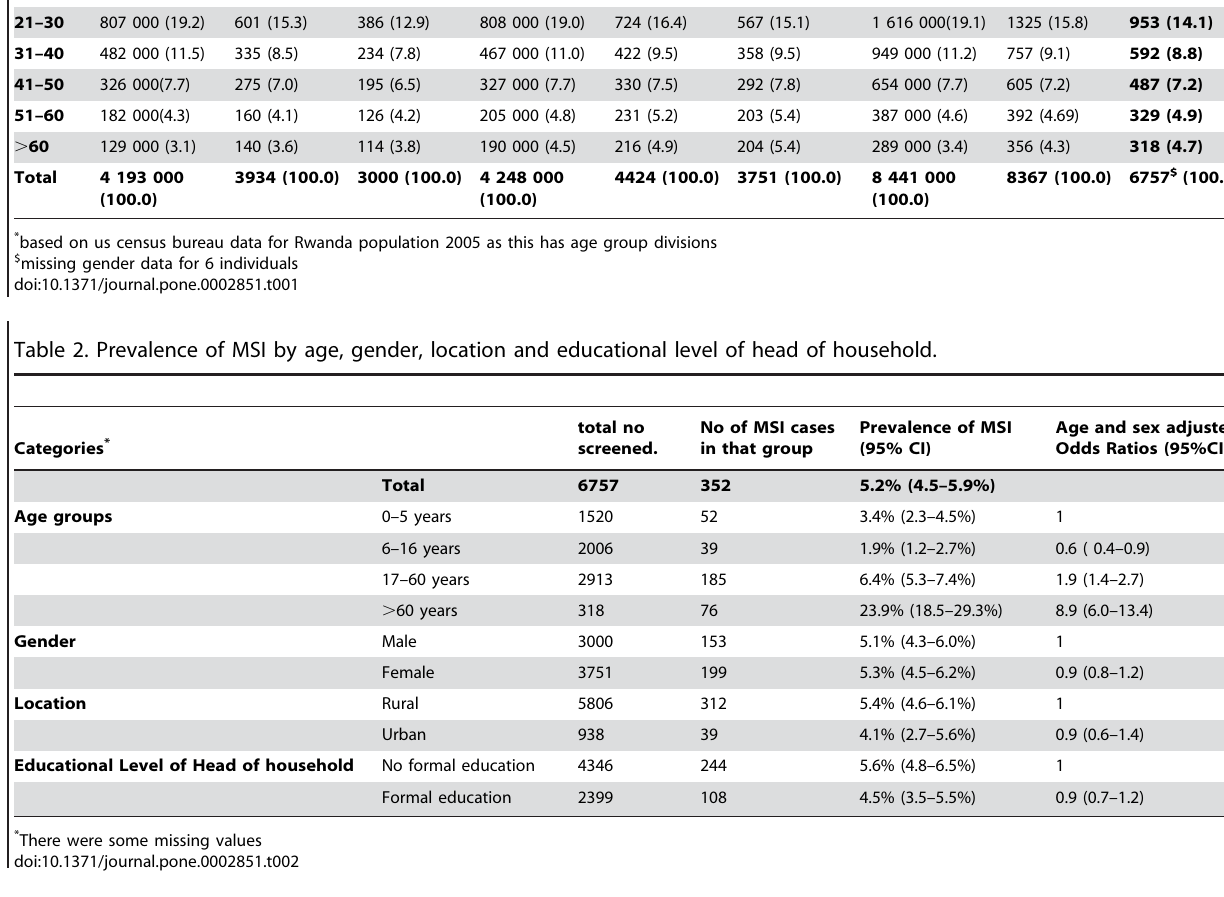
Table 3. Distribution of MSI according to severity and gender, and its association with quality of life.